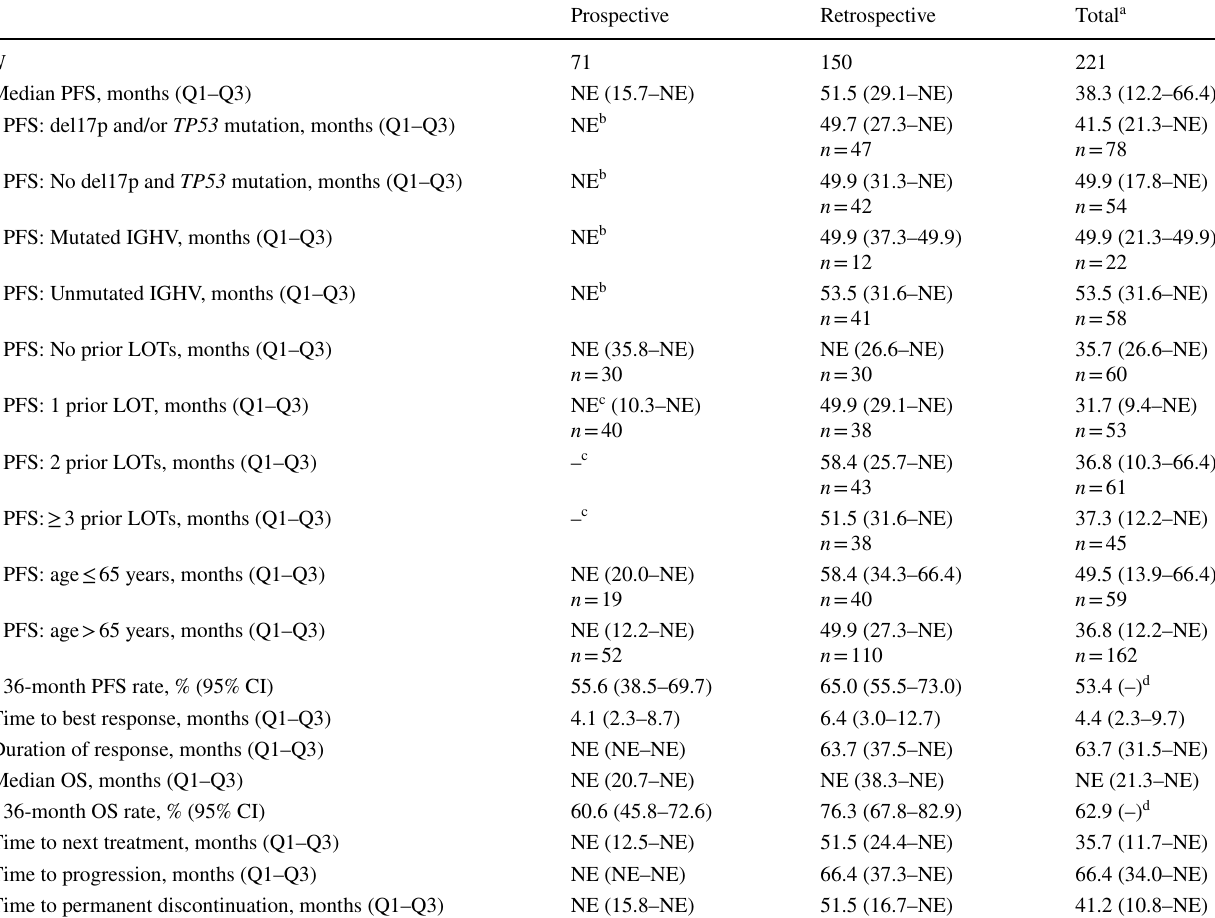
Table 2 Response